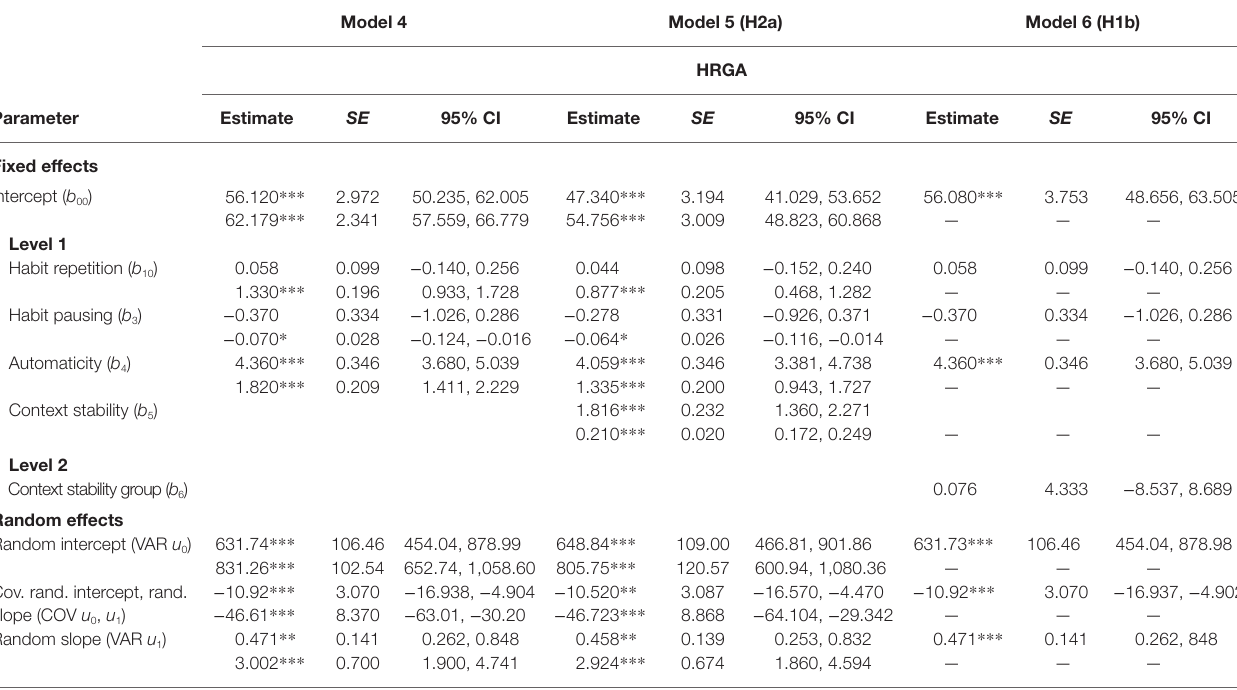
TABLE 3 | Multilevel regressions of HRGA on context stability based on controlled study data with manipulated context stability (Study 1, upper value) and real-life user data (Study 2, lower value).